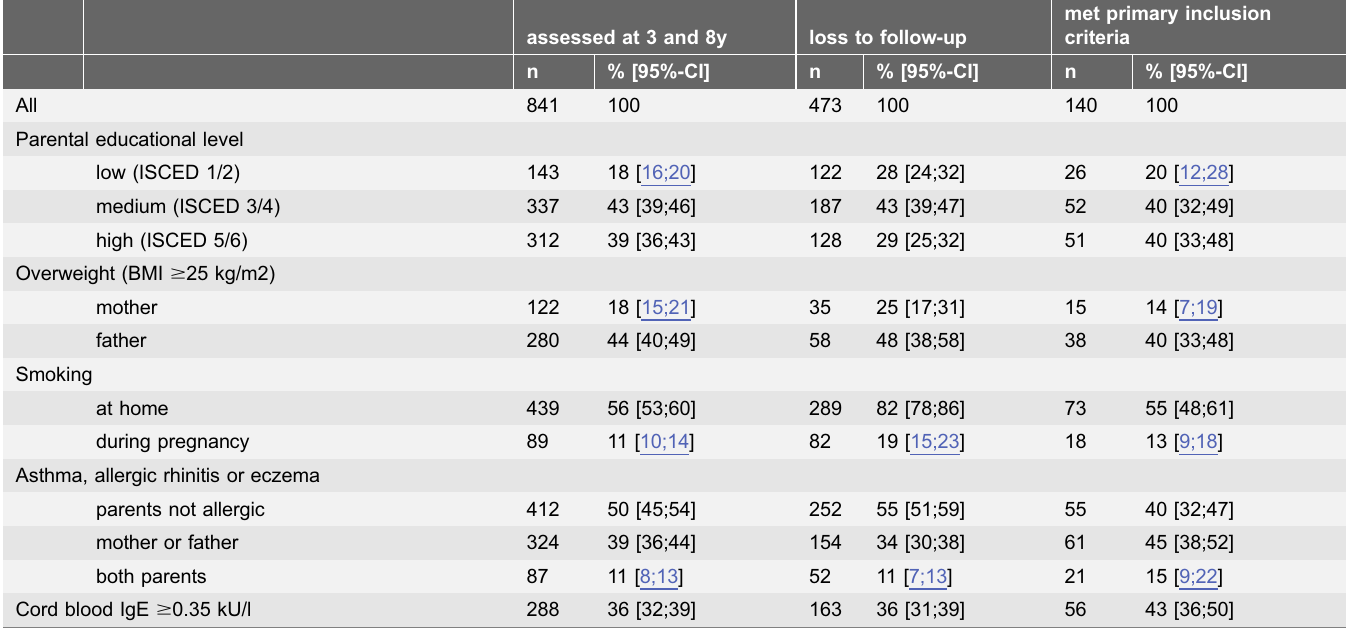
Table 2. Characteristics of families in sample used for external validation, by follow-up